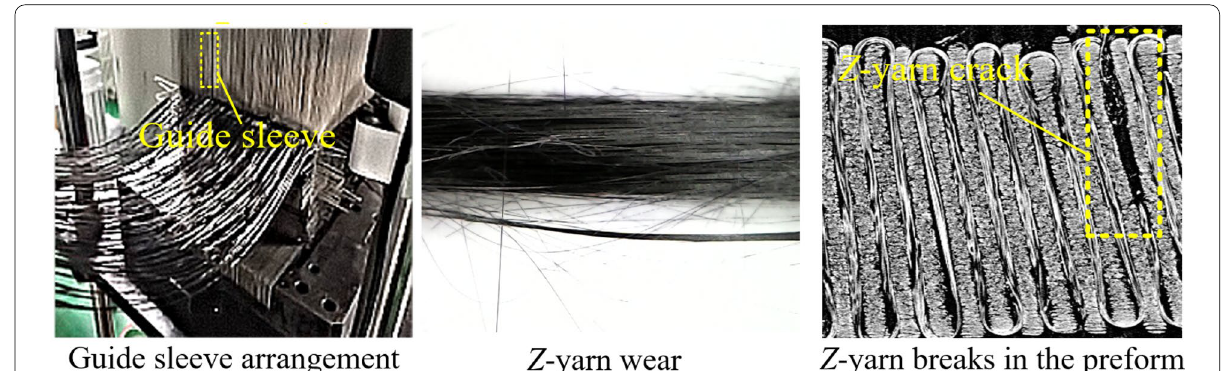
Figure 4 Z -yarn implantation